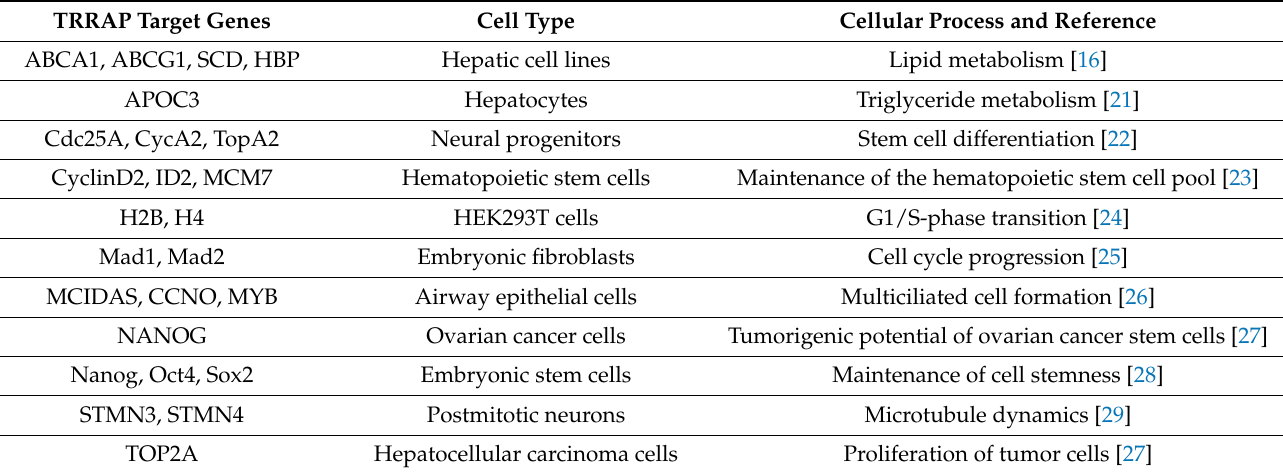
Table 1. TRRAP target genes and their respective involvement in cellular processes. TRRAP Target Genes Cell